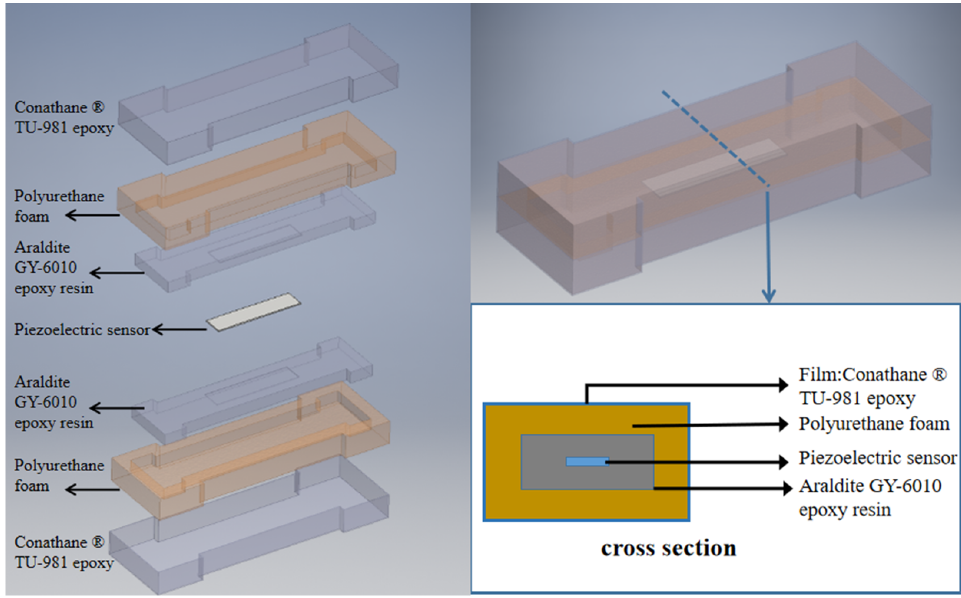
Figure 1. Configuration of the strain sensor.